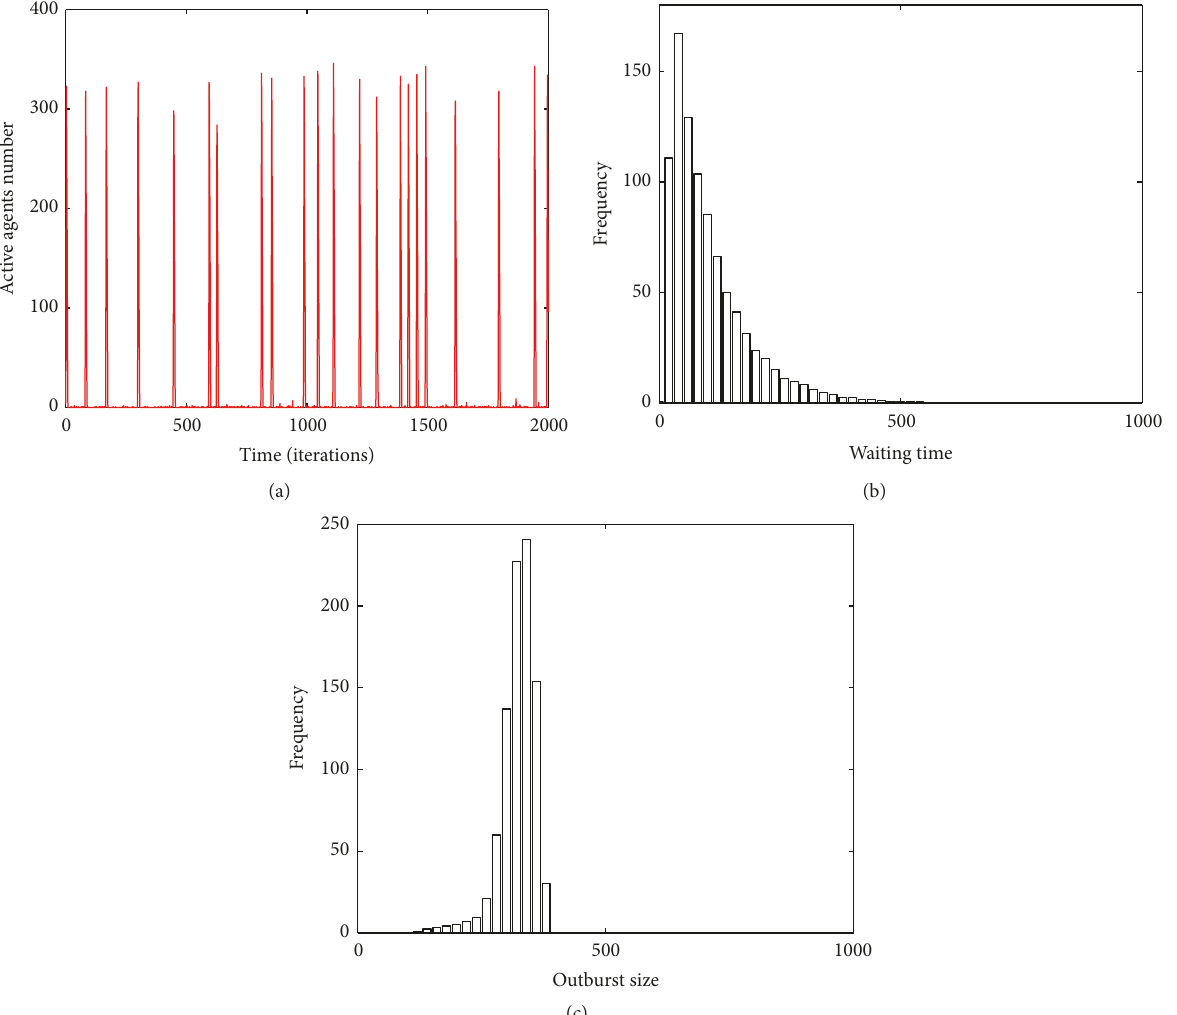
Figure 1: Results obtained when reproducing the model of Epstein [8]. Panel (a) shows the temporal evolution of the number of agents participating in a protest. The red line represents the number of active agents in the system. The observed events correspond to the phenomenon of punctuated equilibrium [30]. In panel (b), the histogram of the waiting times is displayed, while in panel (c), the histogram of the outburst sizes is displayed. For these results, we considered 50 experiments of 10 5 iterations and the parameters shown in Table 1.